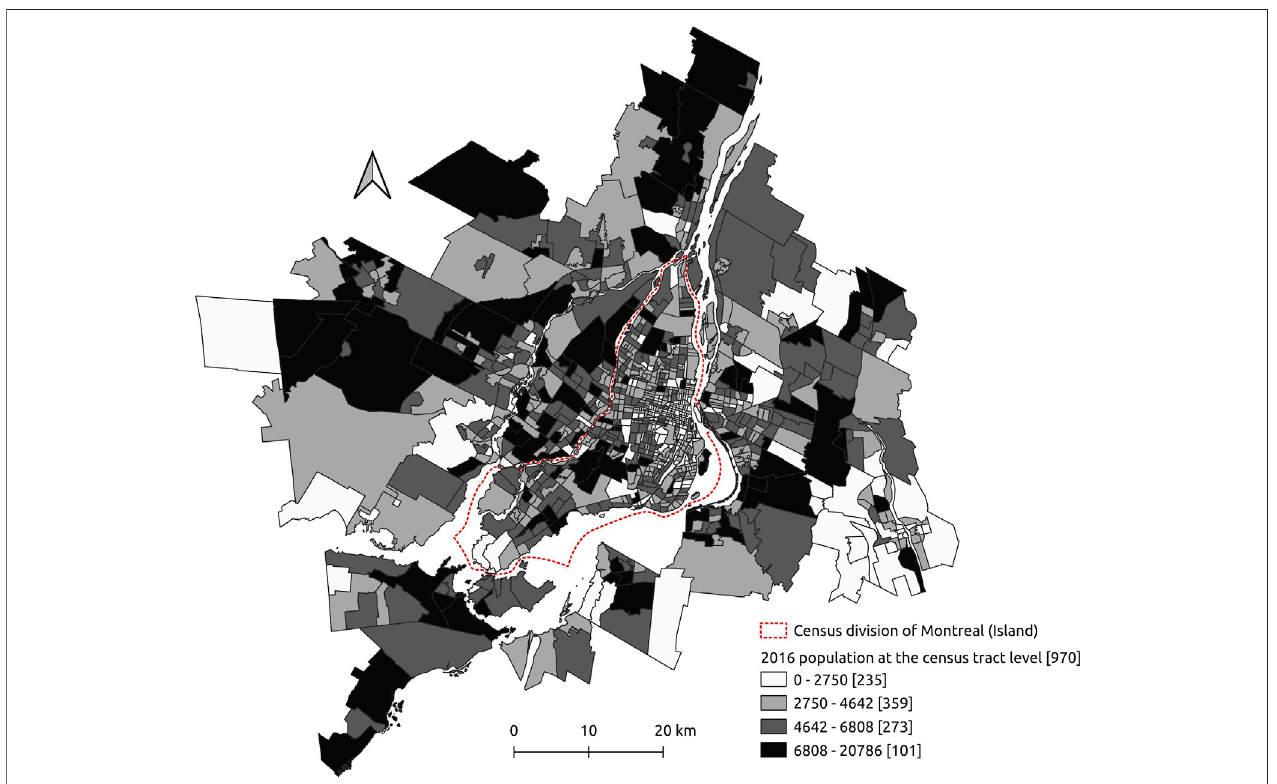
FIGURE 3 | The census metropolitan area of Montreal and its 2016